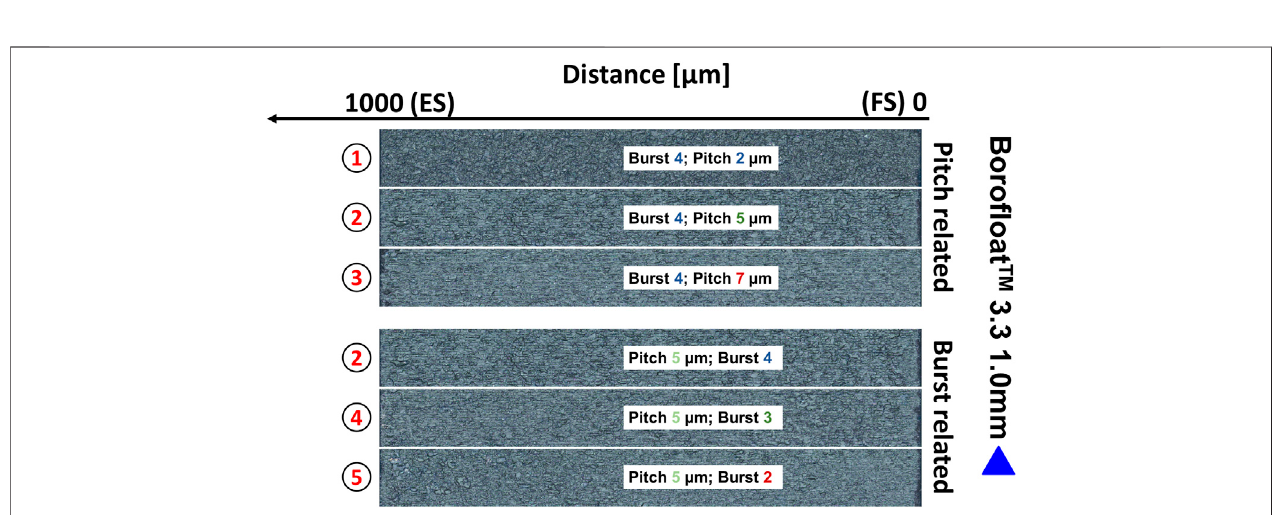
FIGURE6| OpticalcrosssectionimagesofthecutedgeofBoro fl oat3.3 ™ obtainedwithLSM.Entry-Sideislocatedattheleft(1,000 µm)andFocus-Sideisatthe right (0 µm). The top three images (numeration at the left) show the cross section in relation to the Pitch and on the bottom the corresponding Burst series is shown. Sample names are mentioned within the images. Scattered fracture pattern is visible for all images throughout.